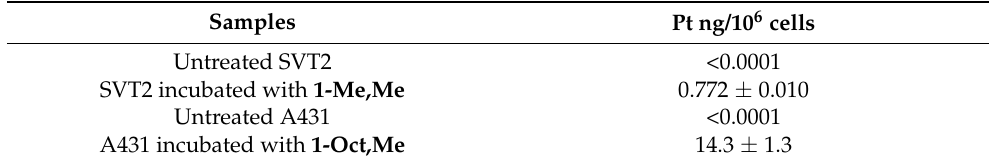
Table 3. The uptake of 1-Me,Me and 1-Oct,Me in cancer cells. Cells were incubated with either 1-Me,Me or 1-Oct,Me , with each one tested at its IC 50 value (9.8 µ M 1-Me,Me on SVT2 and 2.3 µ M 1-Oct,Me on A431). After 48 h, cells were analysed by ICP analysis, as described in the Materials and Methods section. Data shown are the means ± S.E. of three independent experiments. Samples Pt ng/10 6 cells Untreated SVT2 <0.0001 SVT2 incubated with 1-Me,Me 0.772 ± 0.010 Untreated A431 <0.0001 images. Black bars, untreated cells; grey bars, treated cells. Data shown are the means ± S.D. of three A431 incubated with 1-Oct,Me 14.3 ± 1.3 independent experiments. * indicates p < 0.05; ** indicates p < 0.01; *** indicates p < 0.001 with respect